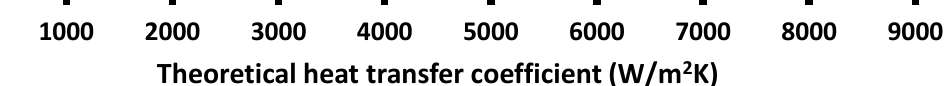
Figure 4. Deviations in the heat transfer coefficient between simulation studies and theoretical calculations.